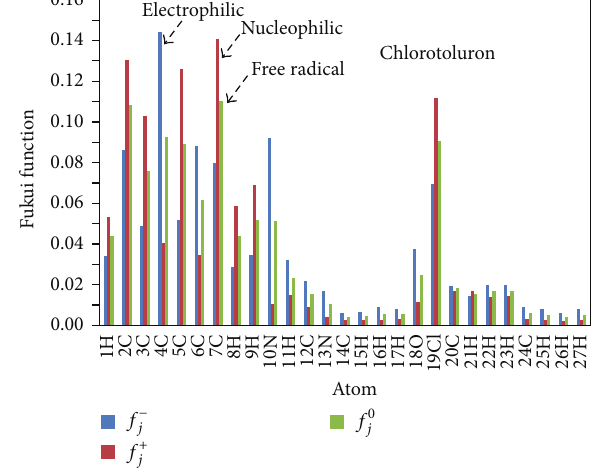
Figure 5: Values of the Fukui function for isoproturon considering Hirshfeld charges according to (7).